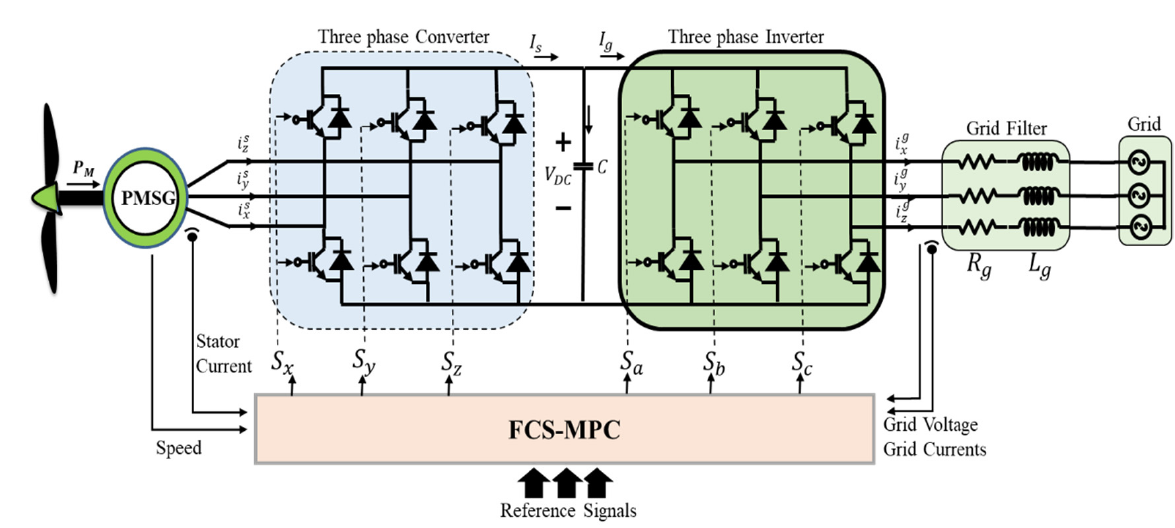
Figure 2. PMSG-based Grid-connected Inverter with FCS-MPC.